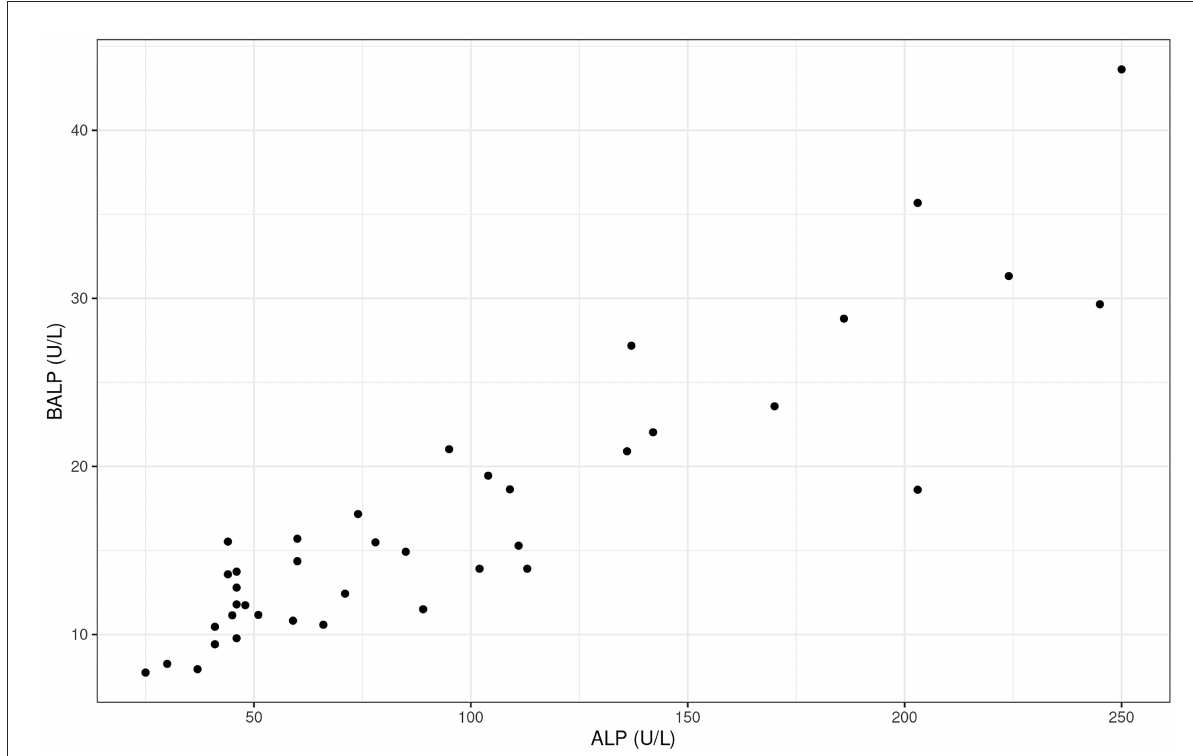
Mean values for serum biochemistry parameters